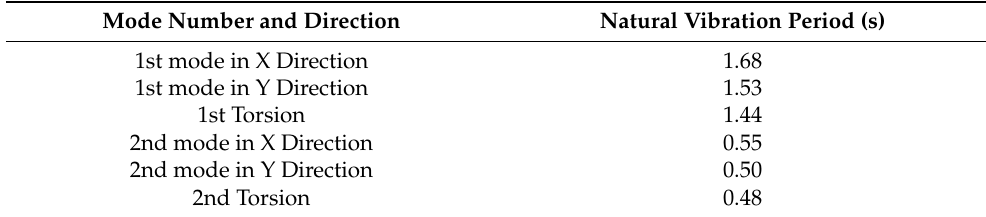
Table 1. Vibration modes and natural